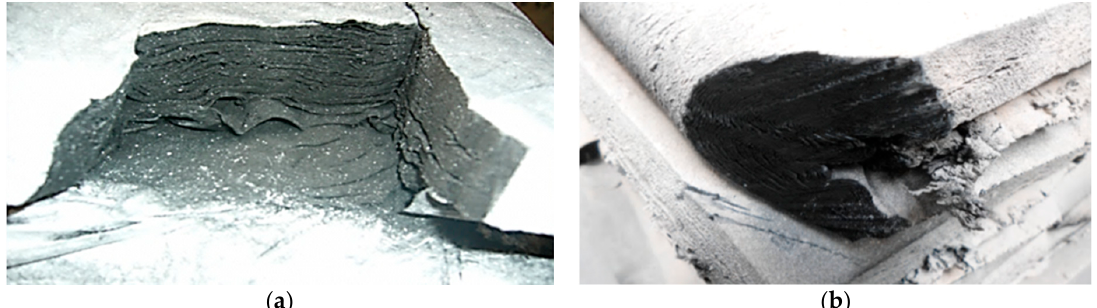
Figure 5. Reclaimed rubber samples. a—the reclaimed rubber sample (RR1) obtained through the classic technology; b—reclaimed rubber sample (RR2) obtained through improved technology. Additionally, by reducing the humidity of the devulcanized rubber, an improvement in the properties of the reclaimed rubber and, implicitly, of the physico-mechanical characteristics of the products that were made with the use of reclaimed rubber can be obtained.